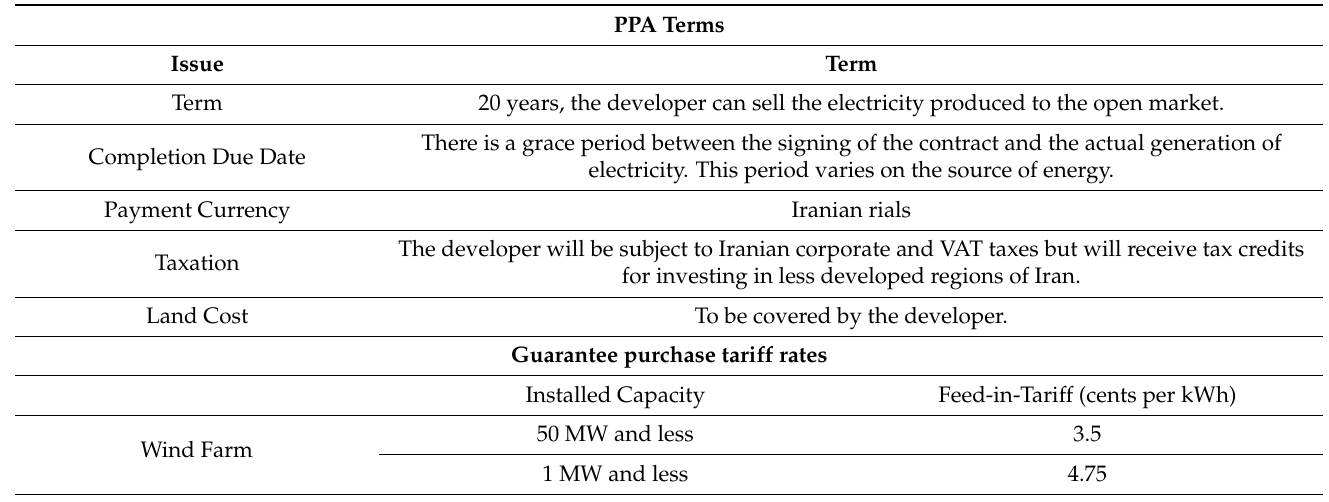
Table 7. Terms of power purchase agreements offered by